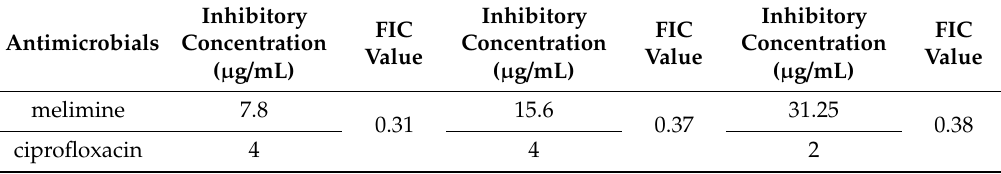
Table 2. Synergistic fractional inhibitory concentration (FIC) values for the combination of melimine and ciprofloxacin against P. aeruginosa 37 .